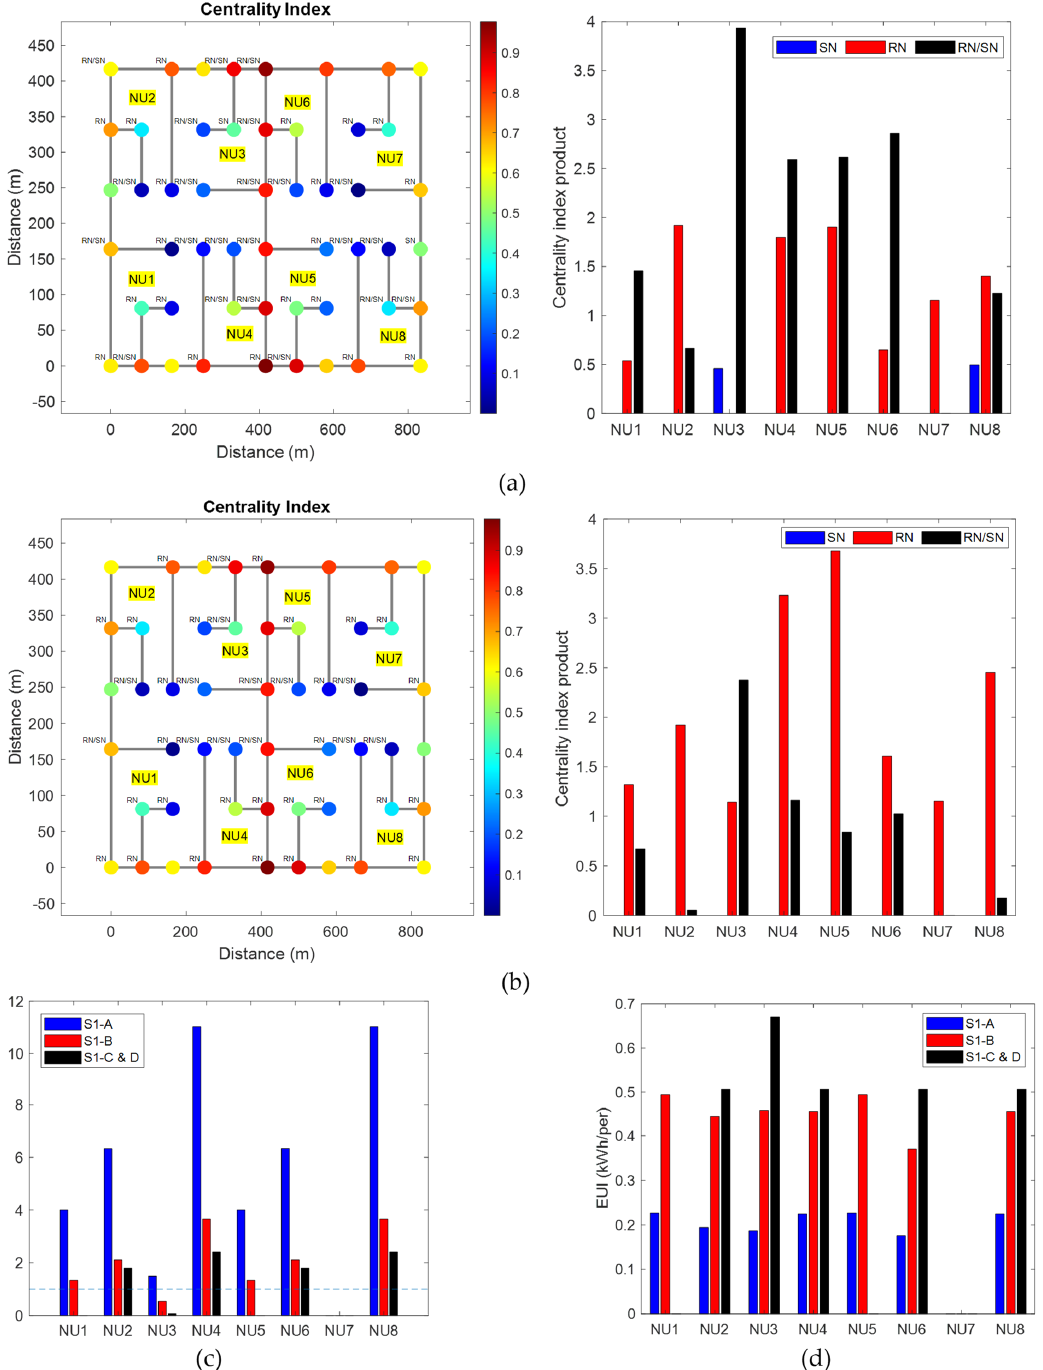
Figure 3. Centrality analysis of combination C2 ( a ) for scenarios S1 − A and S1 − B, ( b ) for scenarios S1 − C and S1 − D along with ( c ) shelter to population ratio (SPR) and ( d ) energy use index (EUI). In Figure 3c,d the shelter to population ratio (SPR) and energy use index (EUI) are indicated for various scenarios. Although the infrastructure resilience is the highest for NU3, its SPR (for S1 ‐ B, C, and D scenarios), it is poor with respect to the denser population